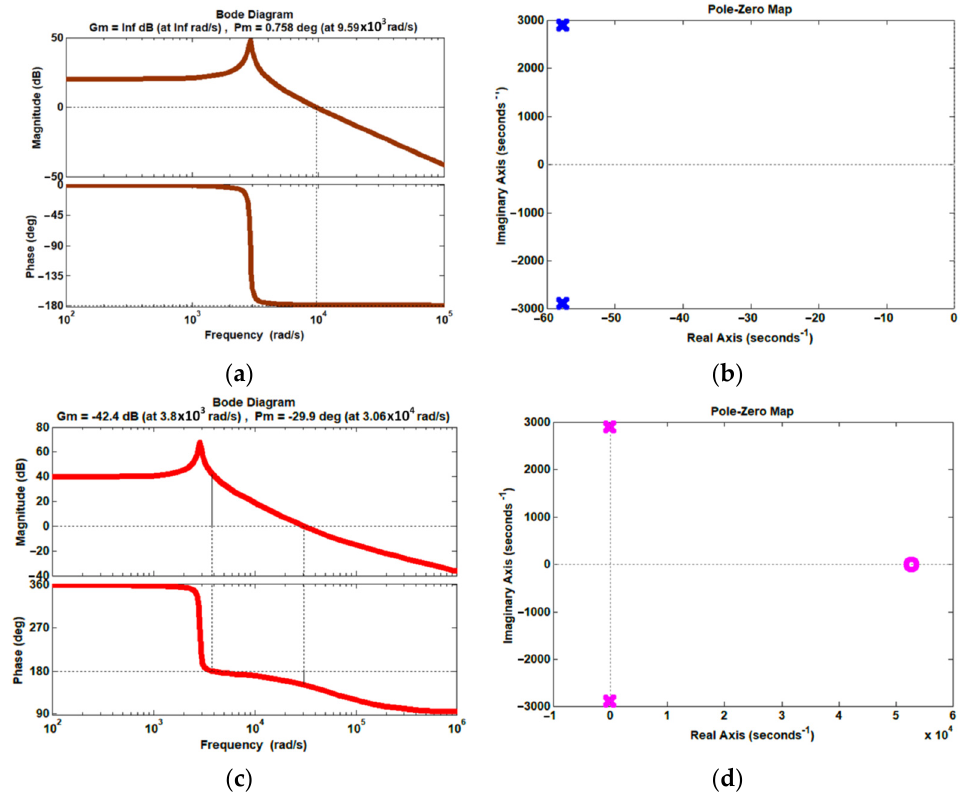
Figure 9. ( a ) Frequency response plot of derived topology; ( a , c ) Bode of Vo(s)/Vg(s) and Vo(s)/d(s); ( b , d ) Pole-zero plot of Vo(s)/Vg(s) and Vo(s)/d(s).